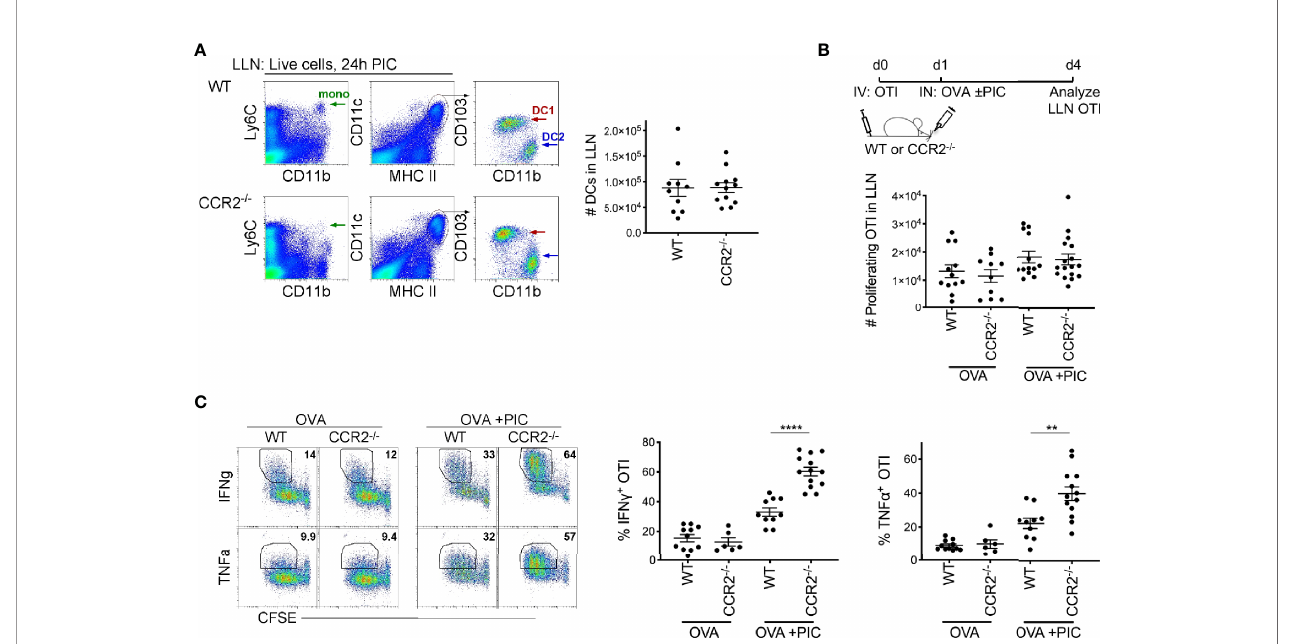
FIGURE 1 | Lymph node monocytes suppress Poly IC-induced antigen-speci fi c cytotoxic CD8 + T cells. (A) Flow plots of LLN from WT and CCR2 -/- mice were isolated 24 hours postimmunization with OVA and Poly IC. Gated live cells illustrate Ly6C + CD11b + monocytes (left plots) and CD11c + MHCII high population (middle plots), CD103 + DC1 and CD11b + DC2 (right plots). Scatter plot, each dot represents a mouse. Total number of migratory DCs in the LLN 24 hours post immunization. Data are 2 independent experiments. (B) Immunization protocol for CTL response, top. Total number of proliferating OTI T cells 3 days post- immunization. Data are cumulative from 3 independent experiments with n = 4 per group. (C) Representative fl ow plots display gating strategy of cytokine production from WT and CCR2 -/- mice, left. Scatter plot analysis of cytokine frequency from individual mice, right. Data are cumulative from 2-3 independent experiments of n = 3,4 per group. Data are shown as mean ± SEM. Each dot represents a mouse. ****P < 0.0001. **P value <